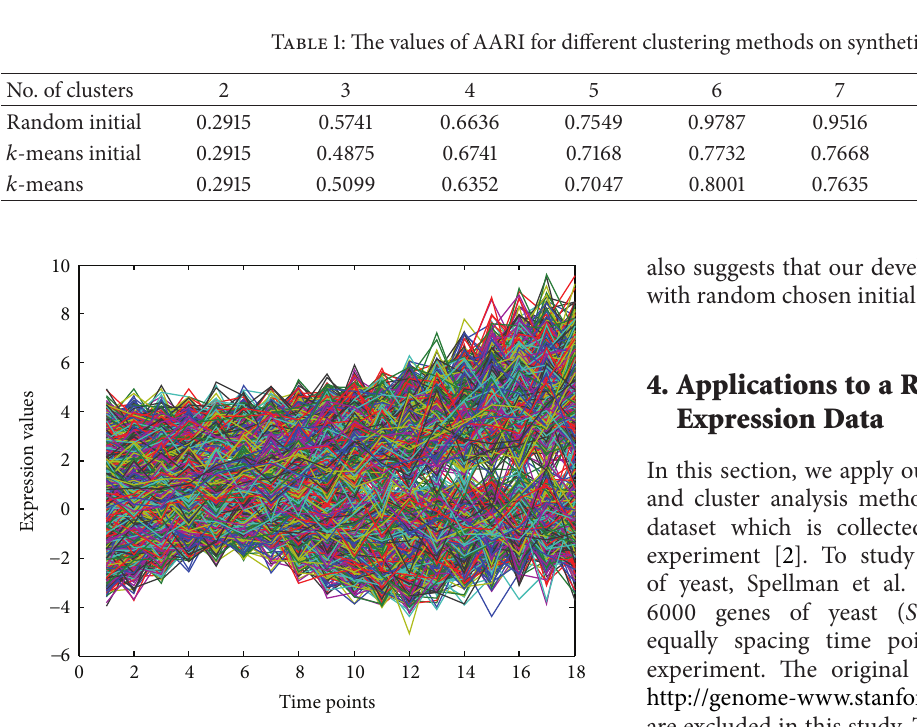
Figure 3: Plot of expression profiles for evaluating cluster analysis method.